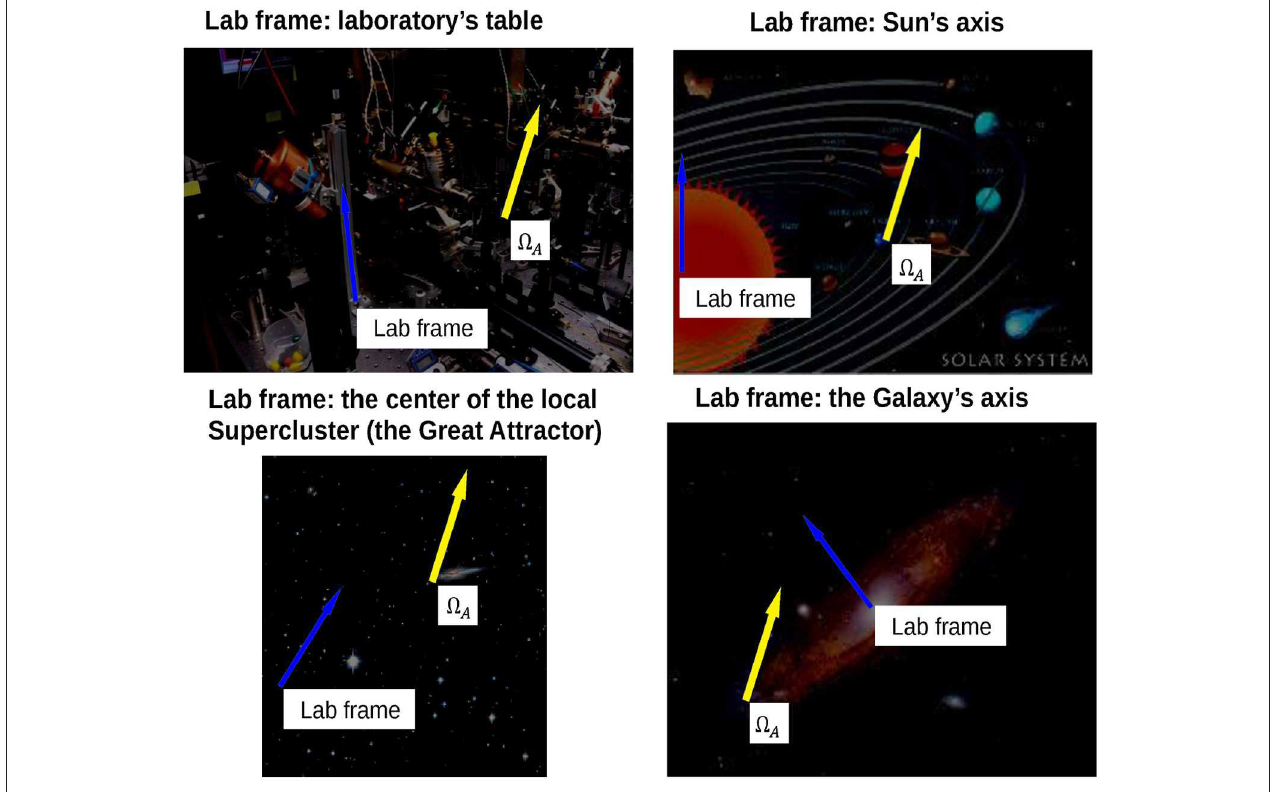
FIGURE 1 | The orientation of the reference direction (cid:127) A with respect to the chosen lab frame is a spurious gauge degree of